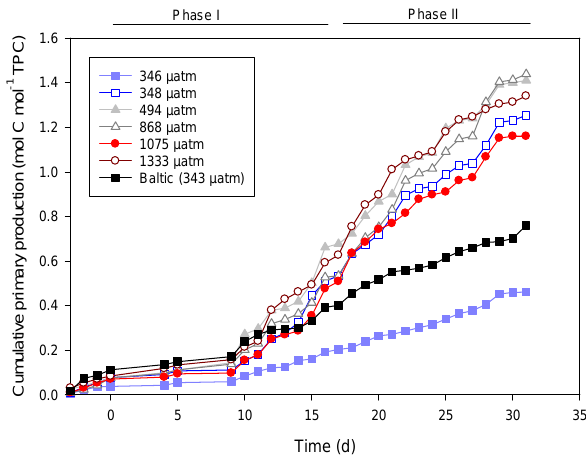
Fig 4 Figure 4. The cumulative primary production in the different f CO treatments normalized to TPC in the euphotic zone. The f CO 2 (µatm) were the average measured over the duration of the exper- iment. The two lowest f CO 2 treatments (346 and 348µatm) were controls without any CO 2 addition. The two phases of the experi- ment are indicated by the horizontal bars on